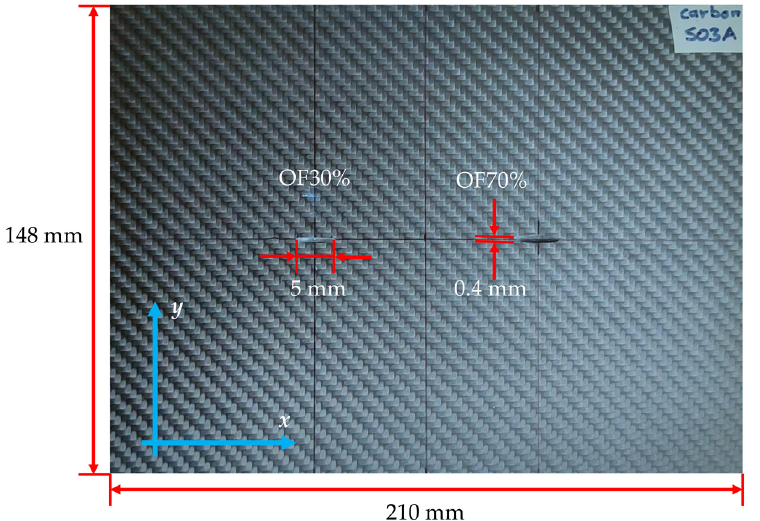
Figure 1. Photo of the sample S03 with the two artificial flaws ( left : OF30%, right : OF70%). The transducer was scanned over the opposite side of the plate.